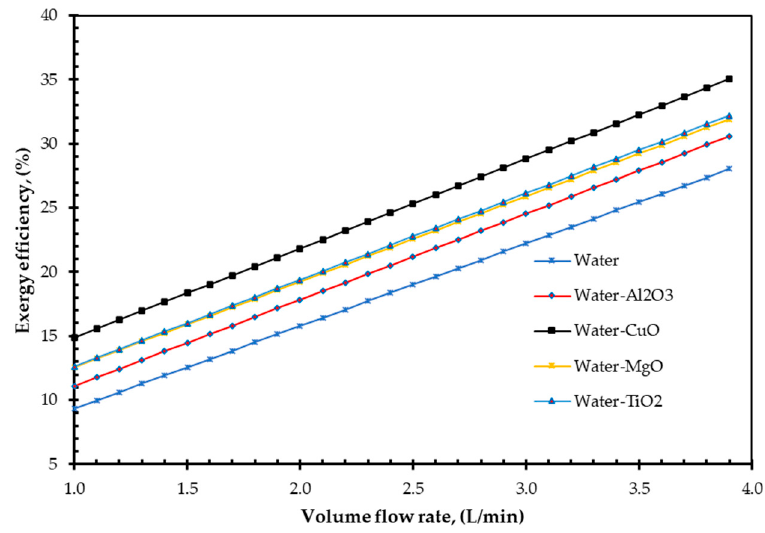
Figure 6. Effect of volume flow rate on exergy efficiency. Figure 7 represents the variation of analytically determined exergy efficiency of